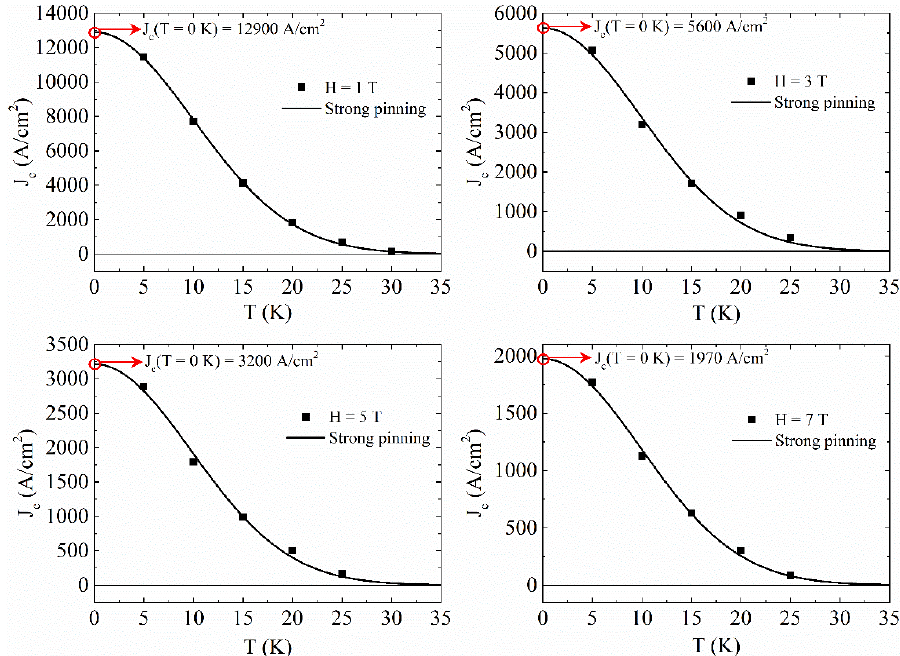
Figure 5. Temperature dependence of J c at different applied magnetic fields fitted with strong pinning model (black solid line).